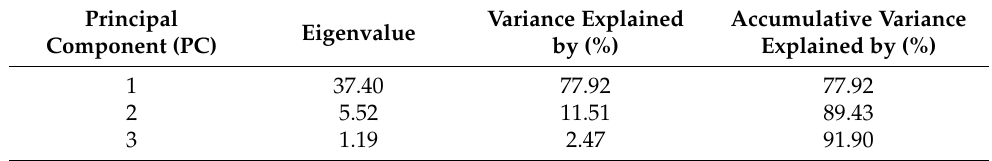
Table 1. Variance explained by the principal components.